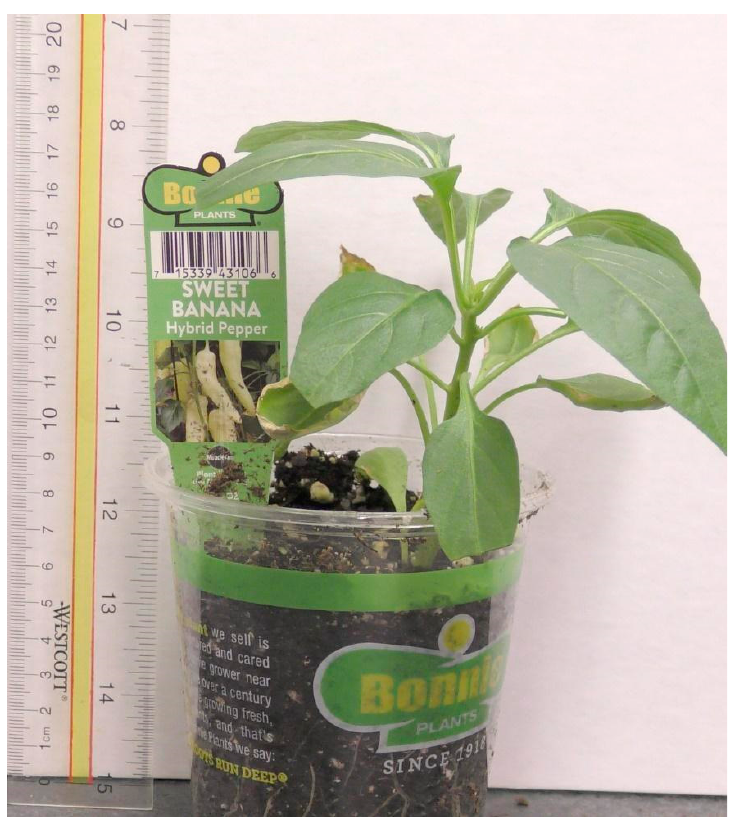
Figure A3. Sweet Banana Hybrid Pepper.